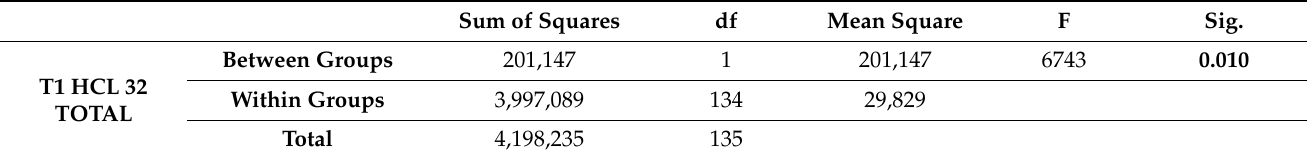
Table 3. Cont. Sum of Squares df Mean Square F Sig.